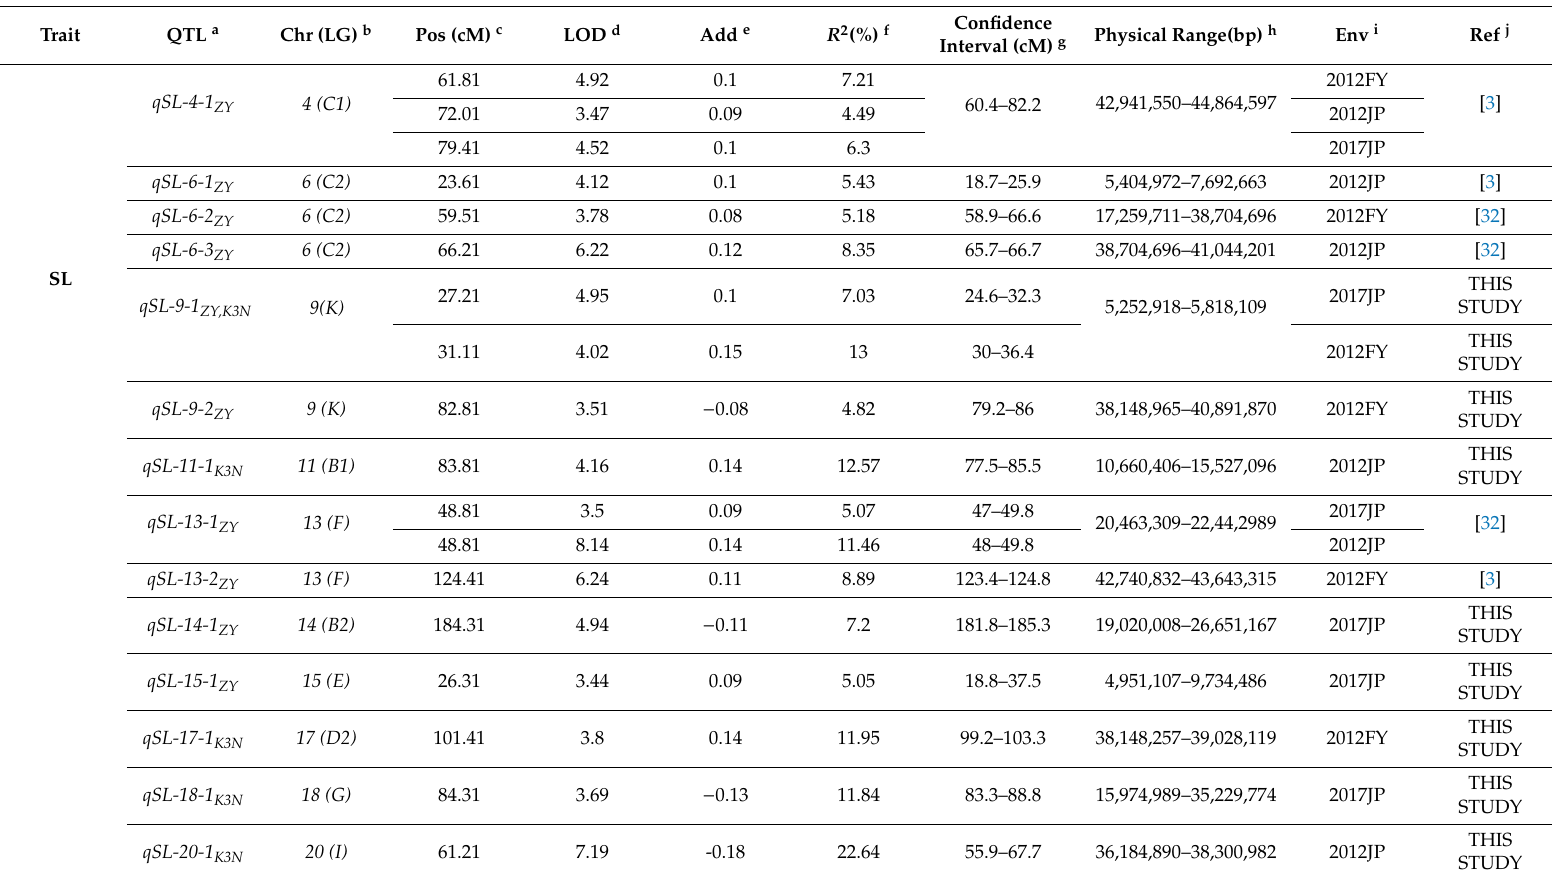
Table 1. Main-e ff ect quantitative trait loci (M-QTLs) identified for three seed-size traits (seed length (SL), seed width (SW), and seed thickness (ST)) in ZY and K3N recombinant inbred line (RIL) populations across multiple